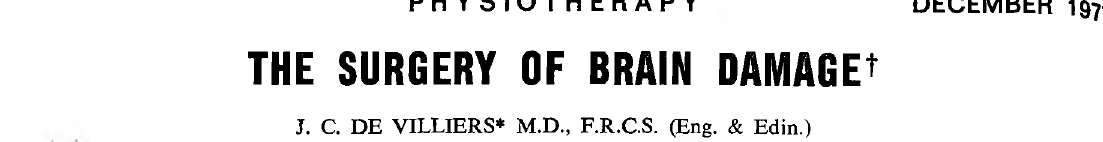
’n Oorsig van chirurge in breinskade word gegee. Voorkomende en palliatiewe chirurgie word kortliks be- spreek. Chirurgie in spastisiteit sluil in neurektomie, risotome en longitudinale mielotomie en die voor- en nadele word bespreek. Serebellere dentatotomie en ander chirurgie vir abnormale bewegings dateer van 1890 en word nog vandag bebruik. Chirurgie in die basale ganglia area word in uitsonderlike ' gevalle aangedui. Ten laaste word chirurgie vir epilepsie en verhoogde intrakraniale druk